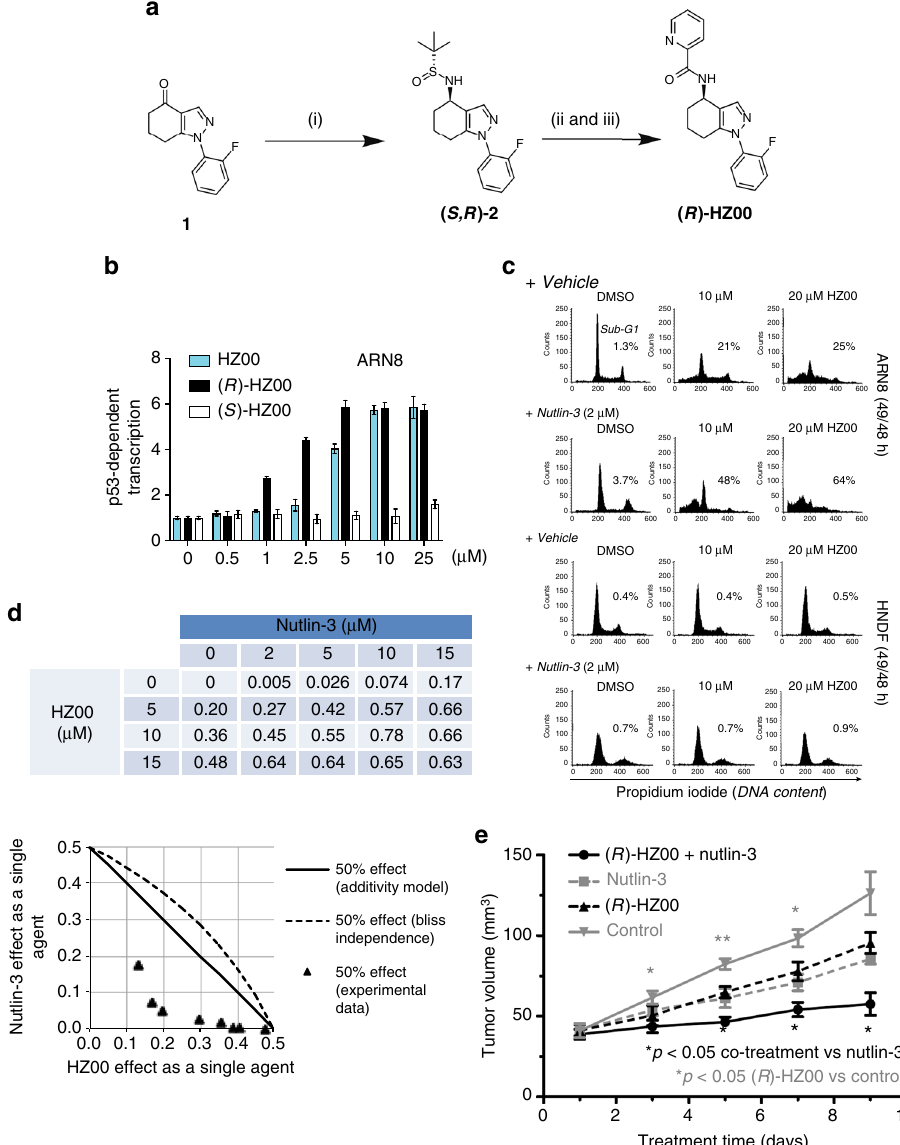
Fig. 2 Synthesis and characterization of HZ00 and its enantiomers. a Synthetic route to ( R ) - HZ00 involving the use of Ellman ’ s chiral auxillary. Reagents and conditions: (i) (1.1) ( S S )-2-methyl-2-propanesul fi namide, Ti(OEt) 4 , THF, 75 °C, (1.2) L-Selectride, THF, − 48 °C, 73%, diastereomeric excess (d.e. 84 %). (ii) HCl, MeOH, RT; (iii) 2-picolinic acid, EDC.HCl, Et 3 N, HOBt, DMAP, DCM, RT, 82% over 2 steps. b p53 wild-type ARN8 human melanoma cells were treated for 16 h with the indicated compounds and the level of p53-dependent transcription measured by CPRG assay. Values correspond to the average of 3 technical repeats ± SD. c ARN8 or HNDF cells were treated with HZ00 for 1 h and then 2 µ M nutlin-3 was added for an additional 48 h. Cells were fi xed and stained with propidium iodide (PI) and analyzed by fl ow cytometry. The percentages of sub-G1 cells are indicated. d ARN8 cells were treated for 72 h with HZ00 and/or nutlin-3 at the indicated doses. After treatment, cell cycle distribution was analyzed by fl ow cytometry following staining with PI. The effect of the compounds was quanti fi ed by obtaining the percentage of cells in sub-G1. The table shows the DMSO control subtracted effect for each dose combination ( d H , d N ). The curves in the normalized EC 50 isobologram for the HZ00-nutlin-3 combination indicate single-effect pairs ( x , y ) = (Eff[ d H ]/100, Eff[ d N ]/100) expected to give a 0.5 effect in combination according to the additivity (solid line) and Bliss independence (dashed line) models 38 , respectively. Data points (triangles) indicate pairs ( x , y ) that give 0.5 effect based on linear interpolation of the experimental data shown in the combination matrix above. e The combination of ( R )-HZ00 (150 mg kg − 1 ) and nutlin-3 (100 mg kg − 1 ) was assayed in a xenograft model of ARN8, and signi fi cantly inhibited growth in this model compared with control groups (i.e., ( R )-HZ00, nutlin-3 or vehicle). n = 5 mice per group. Error bars illustrate ± SEM. (*** p < 0.001, ** p < 0.01 and * p < 0.05). P -values were calculated using multiple Student ’ s t using literature values which report human plasma uridine concentration as between 2.5 and 4.9 μ M and murine plasma uridine concentrations from 1.2 to 3.2 μ M 11 . Indeed, we found effects of HZ00 (Fig. 4e). These observations indicated that HZ00 that ( R )-HZ00 was still successfully able to markedly reduce tumor cell growth at 2.5 μ M uridine and even at up to 5 μ M uridine (Fig. 4f). reduce cell growth of tumor cells at physiological levels of uridine